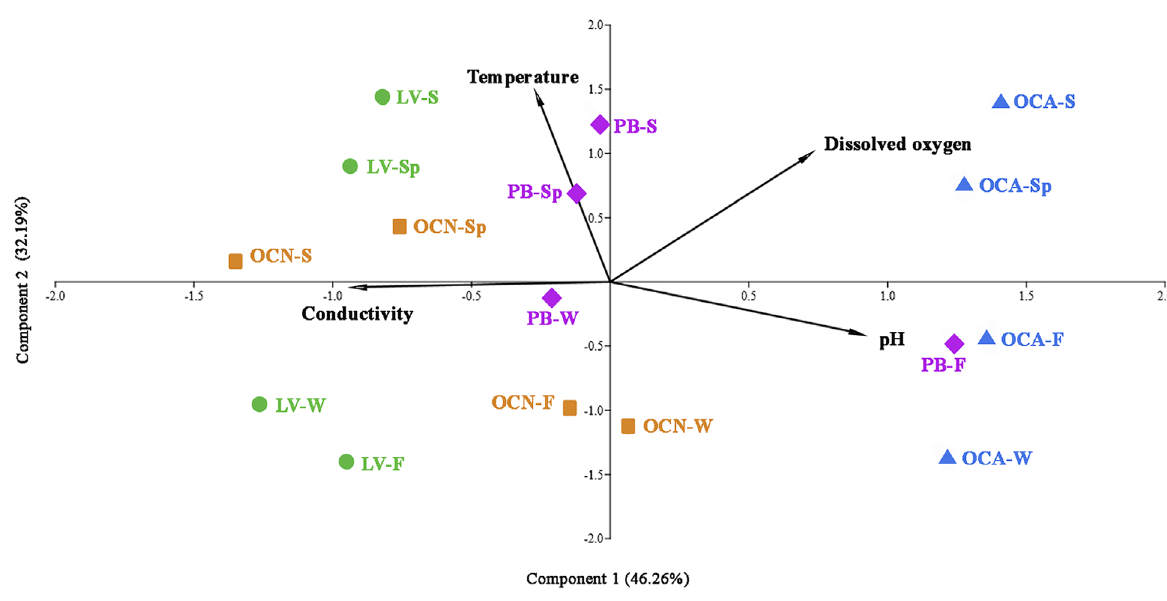
Figure 2. Principal Component Analysis biplot. Variables: Temperature (°C), pH, Dissolved Oxygen (mg/l), Conductivity (mS/cm). LV: Laguna Verde; PB: Pozo Bravo; OCA: Ojo de Campo Azul; OCN: Ojos de Campo Naranja. F: fall; W: winter; Sp: spring; S: